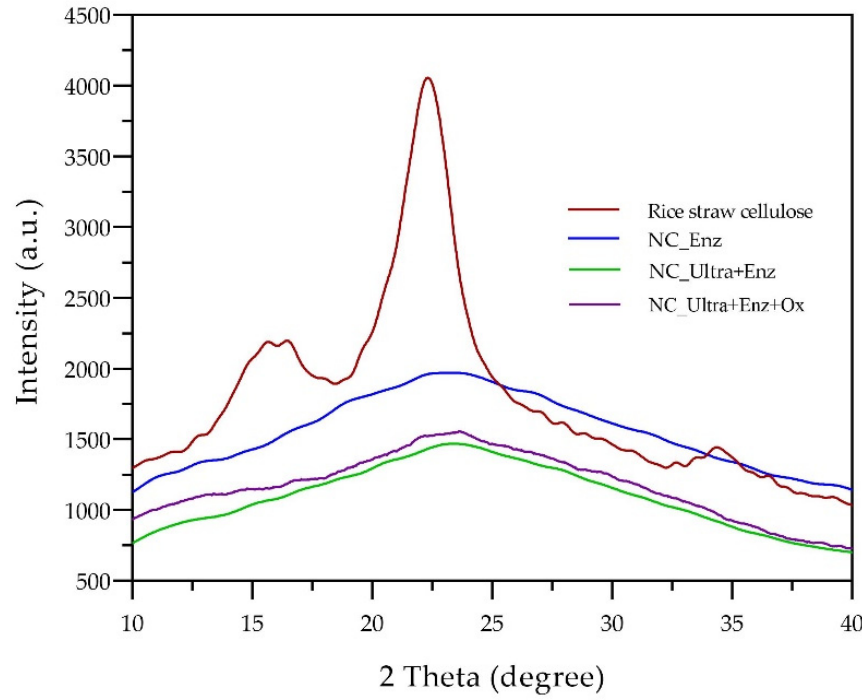
Figure 7. XRD diffractogram of rice straw cellulose and nanocellulose from rice straw cellulose hydrolysis via integrated biobased approaches; enzymatic hydrolysis (NC_Enz), ultrasonication prior to enzymatic hydrolysis (NC_Ultra + Enz), and intensification by oxalic acid hydrolysis (NC_Ultra + Enz + Ox). Table 5. The crystallinity index of rice straw nanocellulose and remaining rice straw cellulose from various integrated biobased processes. Sample